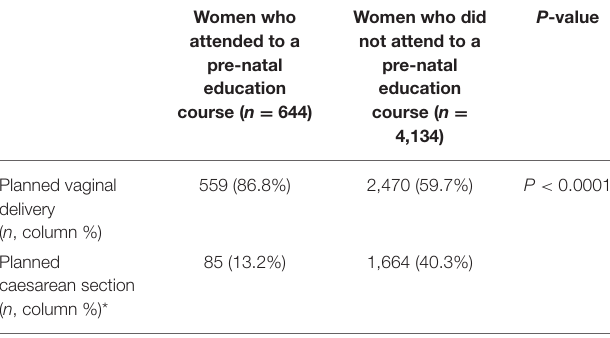
TABLE 2 | The comparison of delivery mode between women who attended pre-natal education course and who did not.